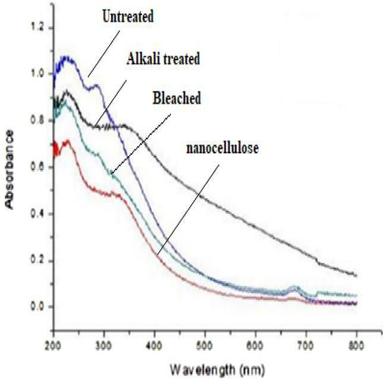
UV–Vis spectra of bamboo fibers: (a) untreated BF, (b) alkali treated BF, (c) acid alkali treated BF and (d) nanocellulose.